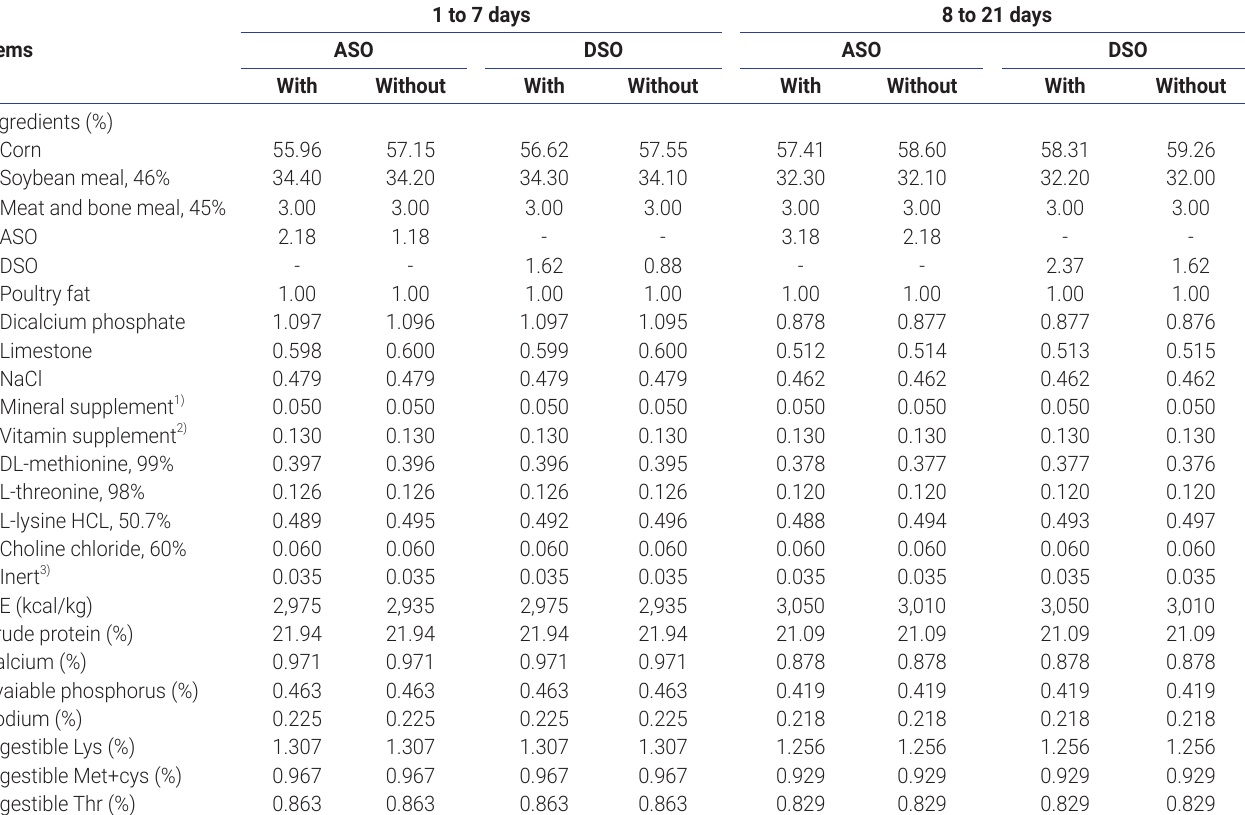
Table 1. Ingredients and chemical composition of experimental diets containing different lipid sources, with or without inclusion of emulsifier, for the pre-starter (1 to 7 days) and starter (8 to 21 days) phases of